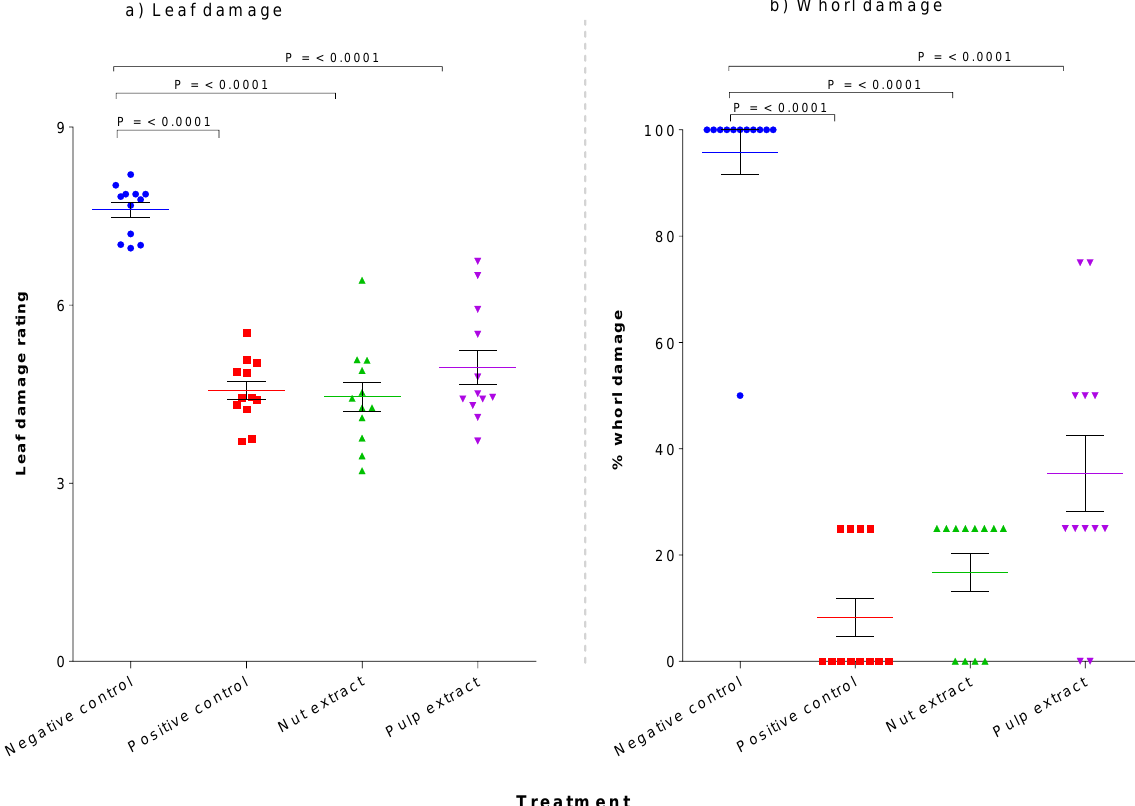
Figure 3. Scatter plot representation of maize leaf damage ( a ) and whorl ( b ) damage for various treatments (2% extracts) ± SEM with 4 technical repeats and 3 independent biological repeats per treatment. p -values, to indicate significant difference, were determined by the Mann–Whitney test.